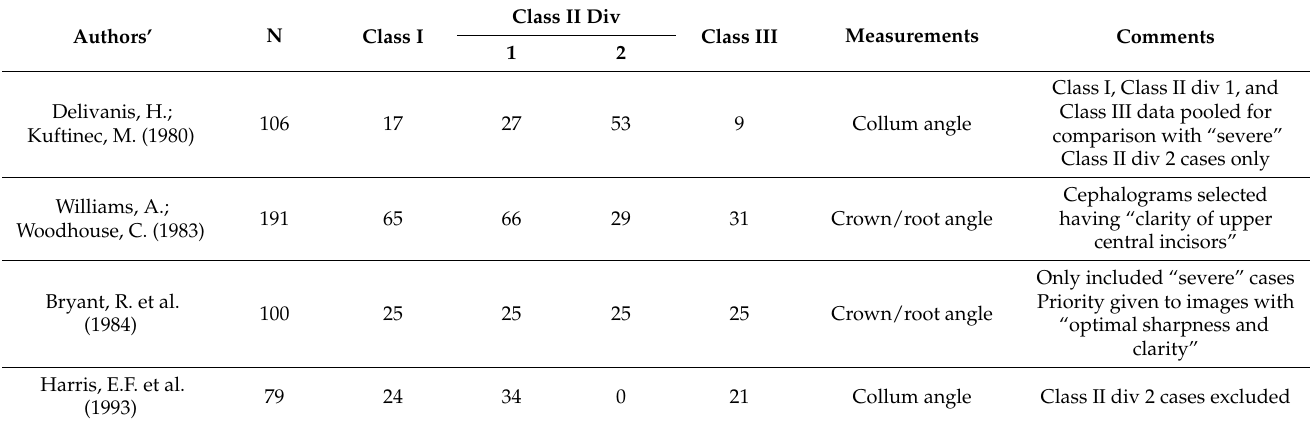
Table 5. Various studies highlighting the measurements and comparison of Class II div 2 with other malocclusion